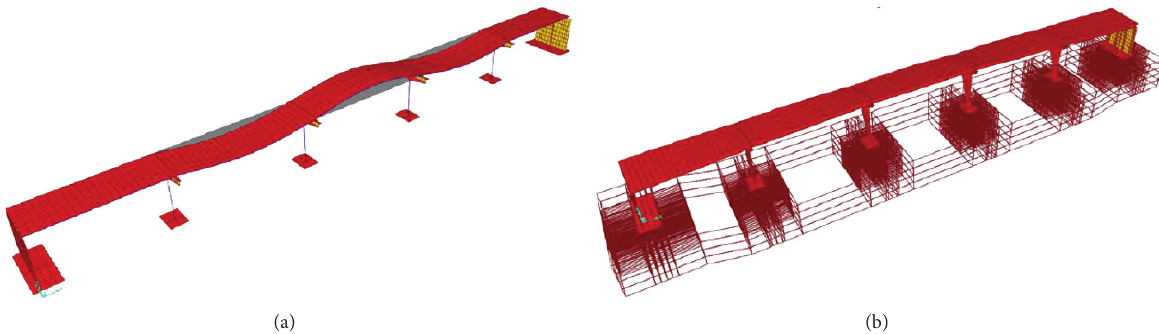
Figure 13: Mathematically identified mode shapes: (a) model AM1, 1st vertical mode; (b) model AM2, 1st transverse mode.